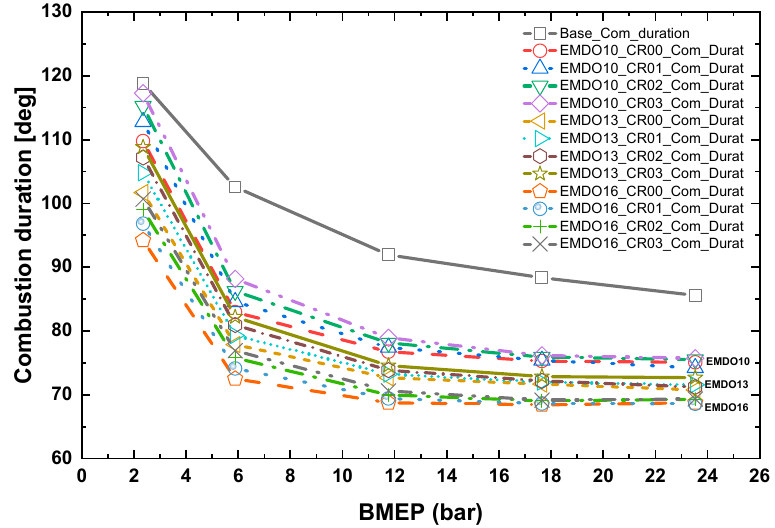
Figure 10. Characteristics of the combustion duration versus three types of emulsified MDOs and four types of turbocharger nozzle rings.